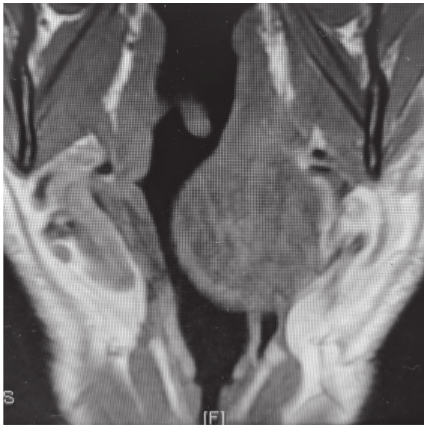
Figure 1: View of mass on axial CT.